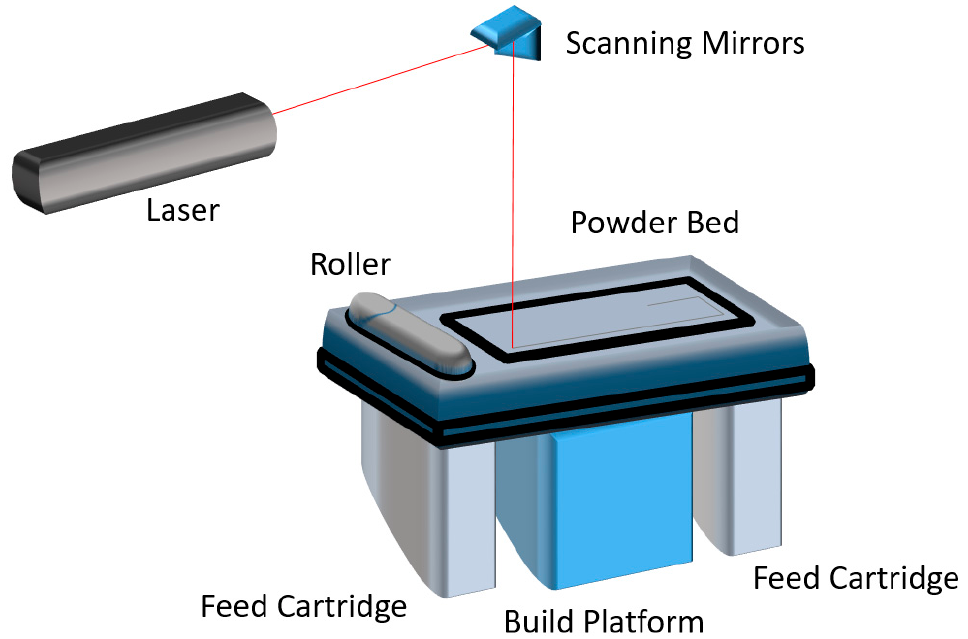
Figure 6. A schematic of a general PBF system.